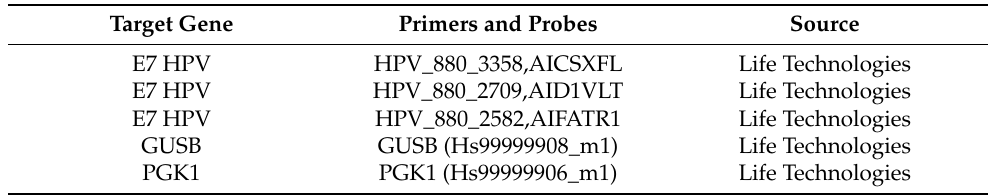
Table 1. Primers and probes used to detect mRNA E7 expression of the HPV types isolated in the cytological